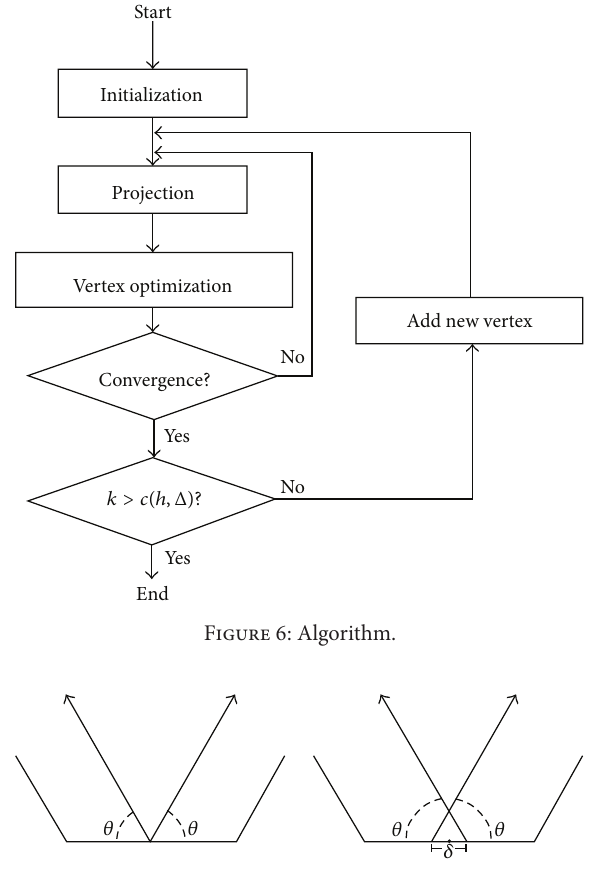
Figure 6: Algorithm.